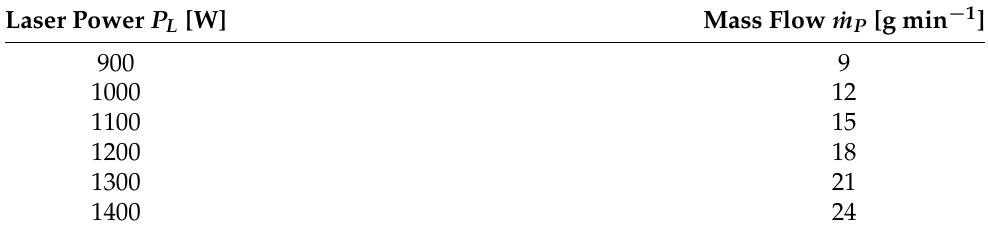
Table A4. Full-factorial design to investigate the interdependencies of focal offset and nozzle standoff.